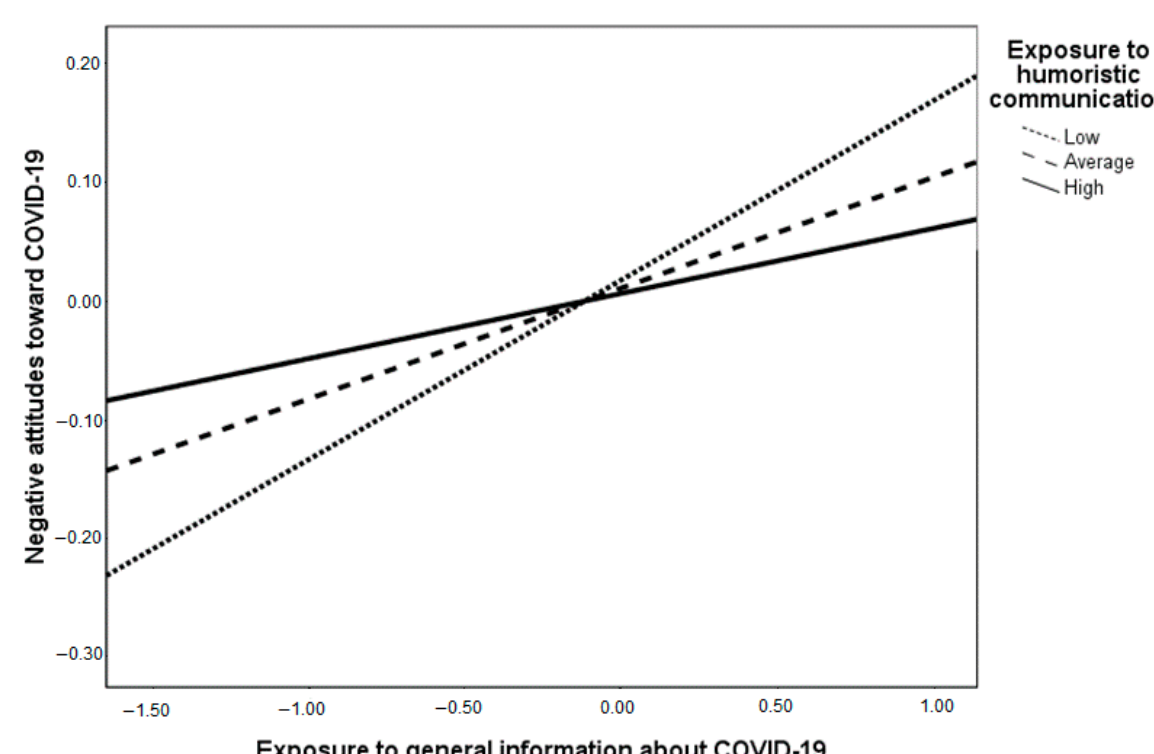
Figure 1. The interaction between exposure to general information and exposure to humoristic communication (EHC) on negative attitudes towards COVID-19. Note: conditional effects of exposure to general information about COVID-19 on negative attitudes are: B (unstandardized regression coefficient) = 0.15, SE (standard error) = 0.03, p < 0.001 for low EHC; B = 0.09, SE = 0.02, p < 0.001 for average EHC and B = 0.05, SE = 0.03, p = 0 .06 for high EHC.